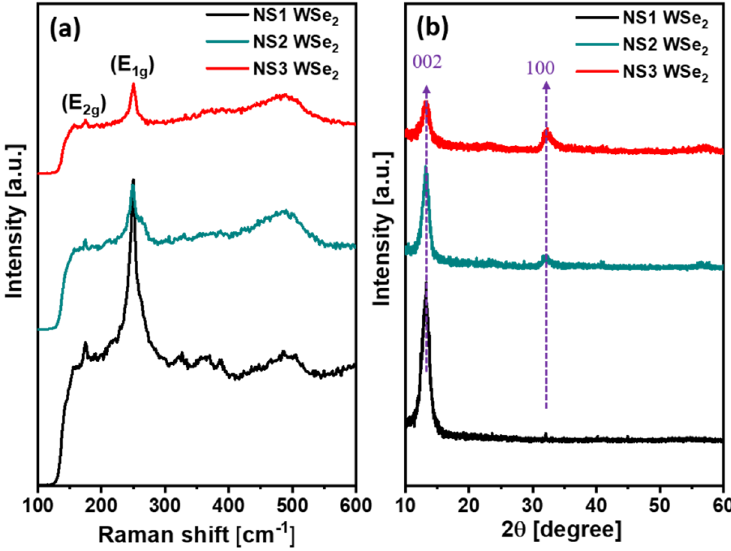
Figure 3. ( a ) Raman spectra and ( b ) XRD patterns of NS1-NS3 WSe 2 NSs.